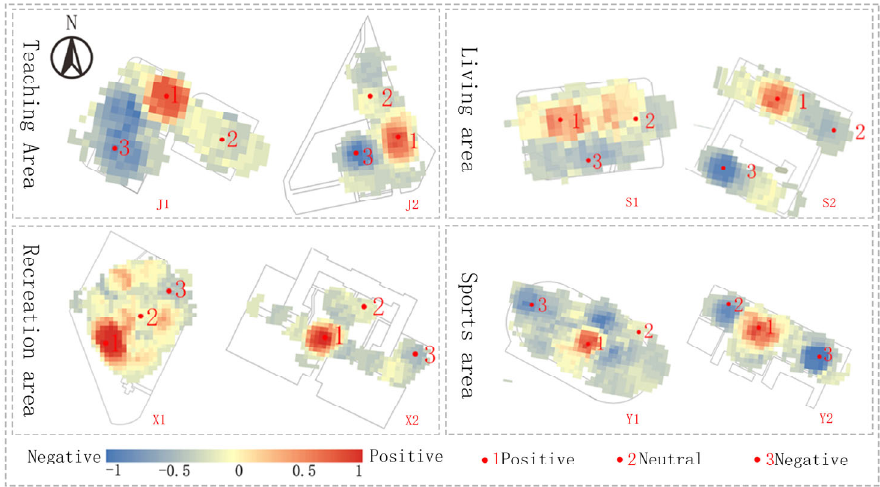
Figure 3. Emotion measurement and emotion map construction process. (Emotion measurement: Measurement of emotions).